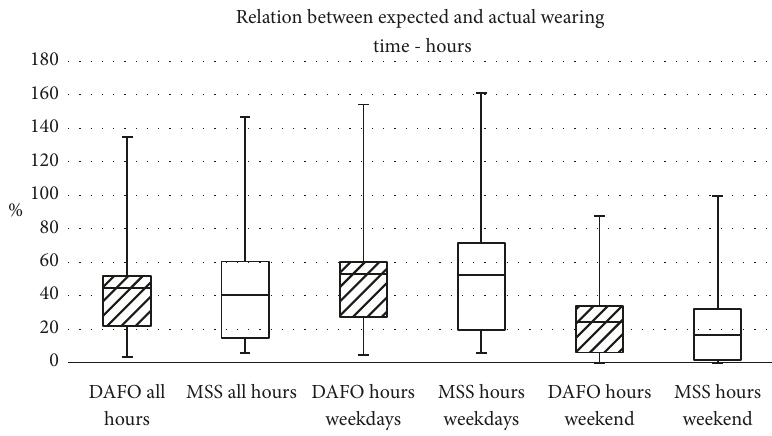
Figure 4: Relation between expected and actual wearing time with focus on the hours worn.